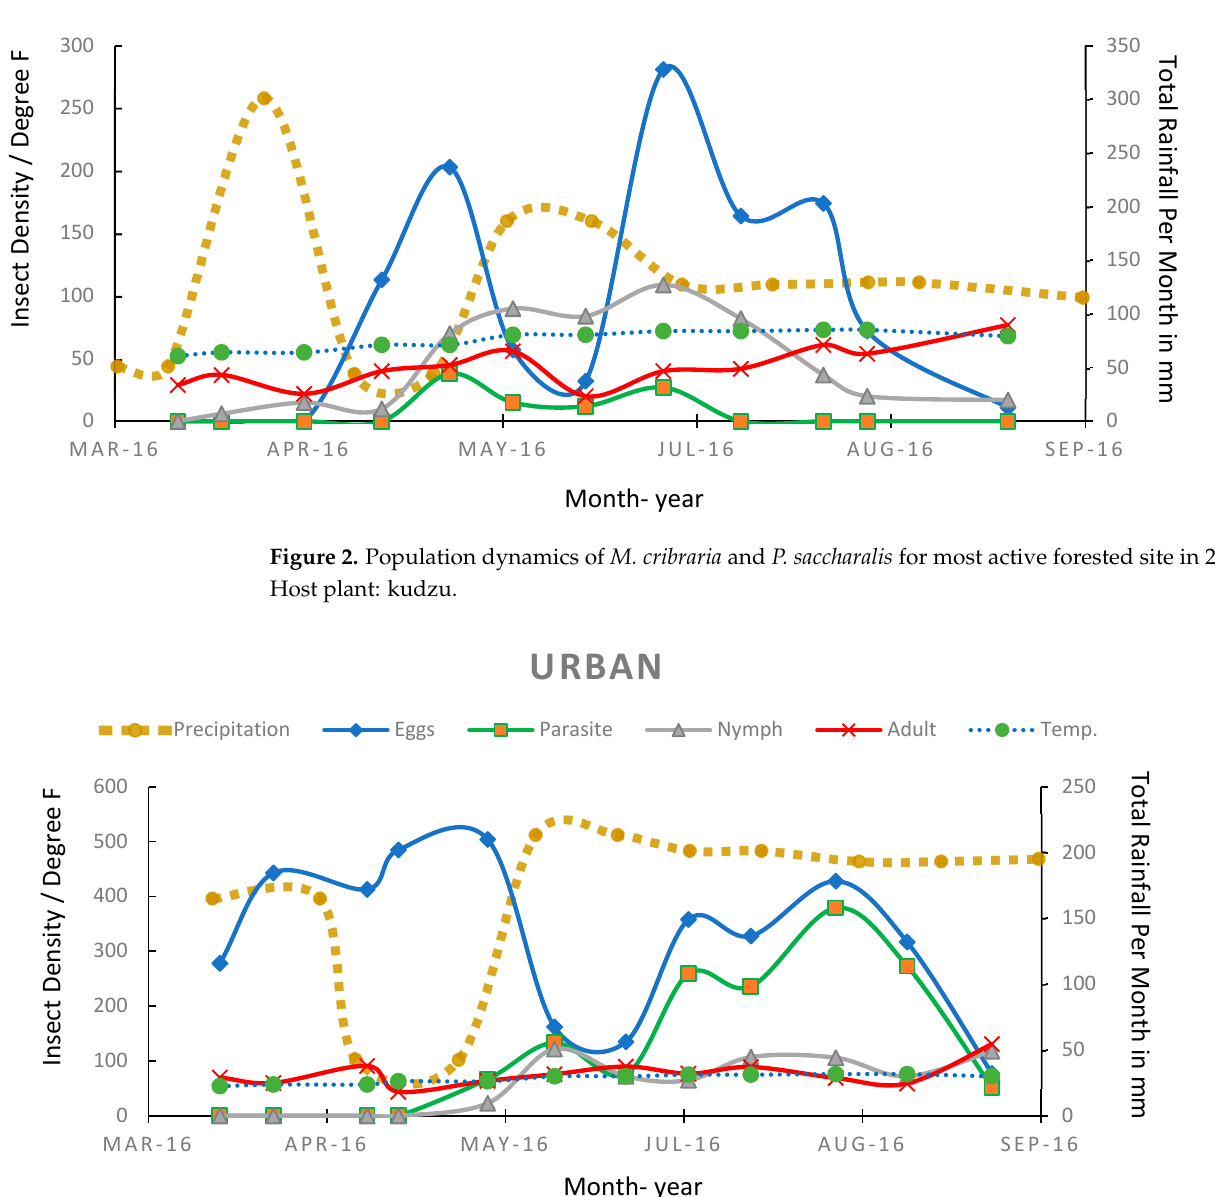
Figure 4. Population dynamics of M. cribraria and P. saccharalis for most active agricultural site in 2016. Host plant: soybean.